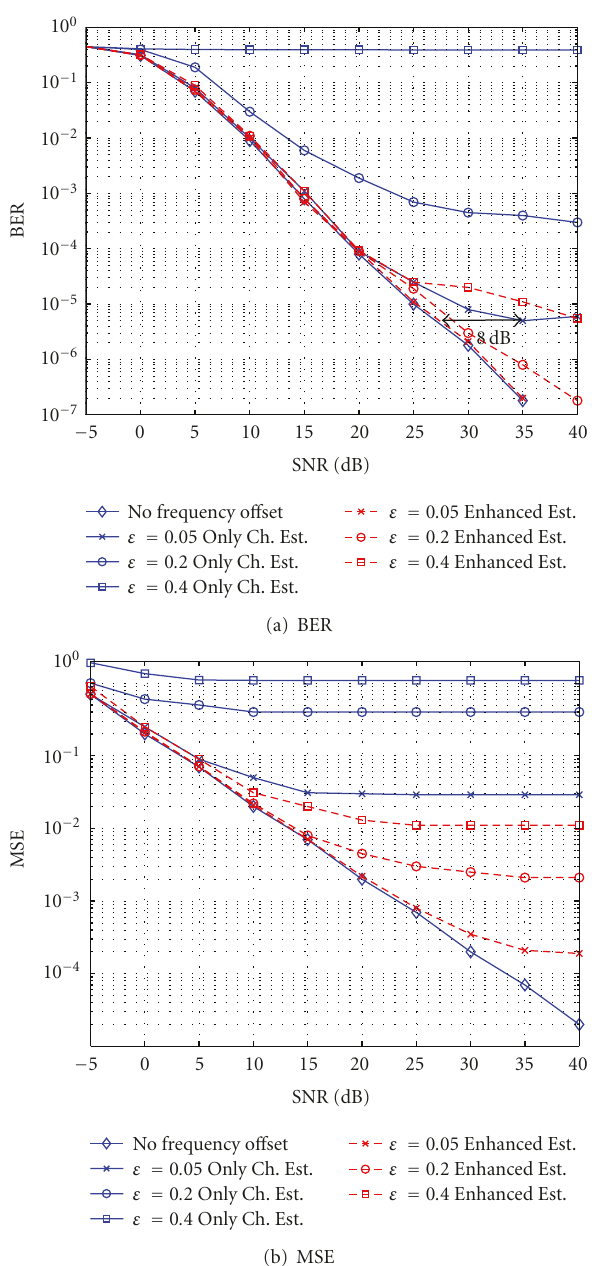
Figure 13: BER and MSE for transmission mode 1: BPSK. The label “Only Ch. Est.” denotes the case when only channel estimation and compensation are used whereas “Enhanced Est.” accounts for the joint enhanced channel and frequency o ff set estimation